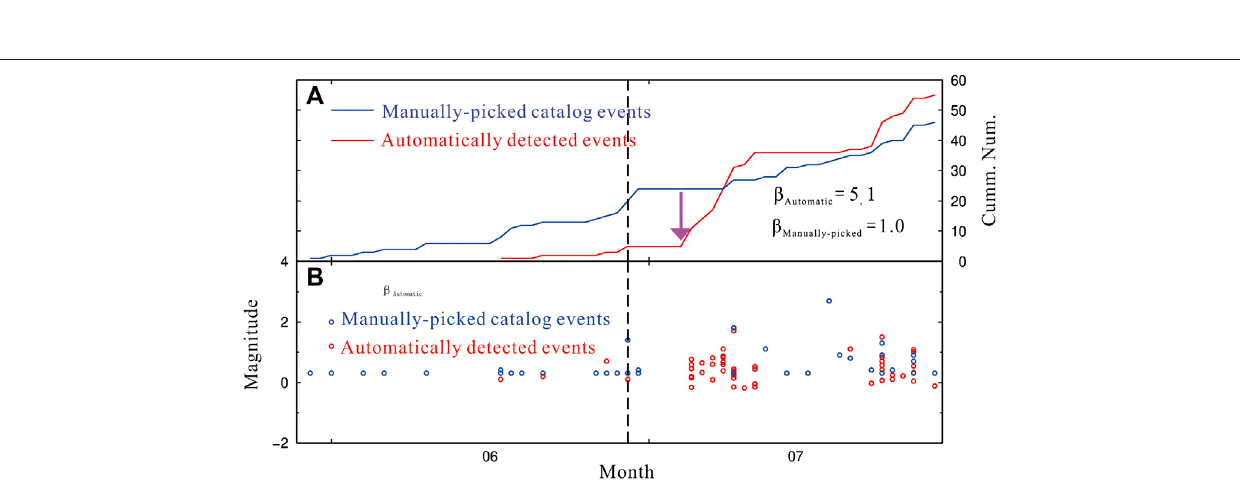
Frontiers in Earth Science |